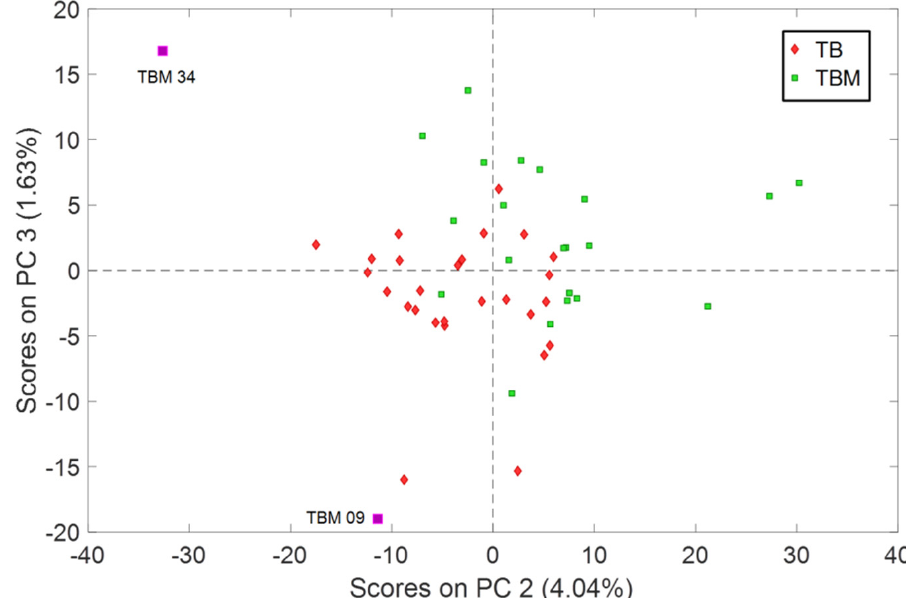
Figure 3. Exploratory analysis: PCA score plots of white Tequilas fused data (TB: ‘100% agave, and TBM: ‘mixed’).